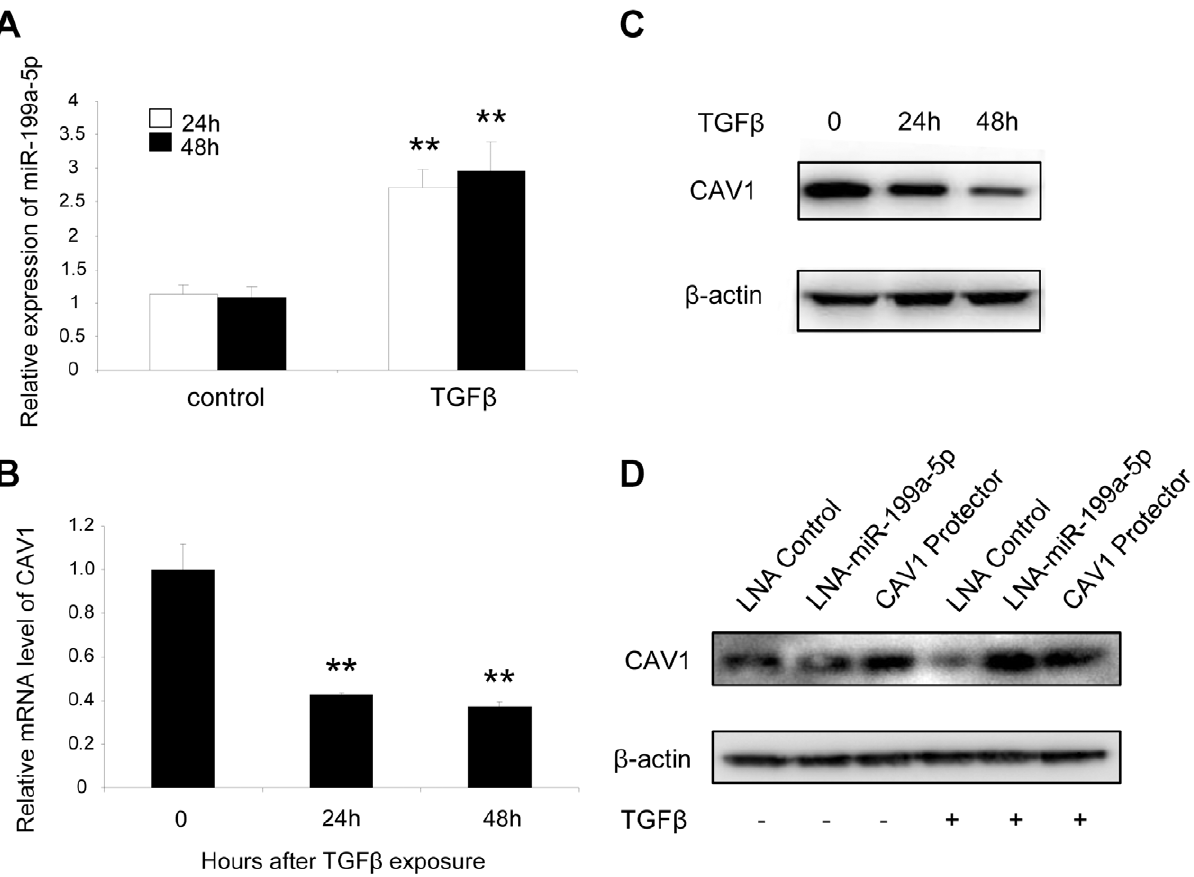
Figure 4. TGF b regulates CAV1 by increasing miR-199a-5p expression. MRC-5 lung fibroblasts were treated with 10 ng/mL TGF b for 24 h and 48 h. MiR-199a-5p (A) and CAV1 expression levels (B) were determined by Taqman PCR. Data are expressed as mean 6 SEM. ** p , 0.01. (C) CAV1 protein levels were determined by immunoblot analysis. (D) MRC5 cells were transfected with LNA-miR-199a-5p, CAV1 protector or LNA-control then incubated with or without 10 ng/ml TGF b for 24 h and CAV1 protein levels were determined by immunoblot analysis. Data are representative of three independent experiments.